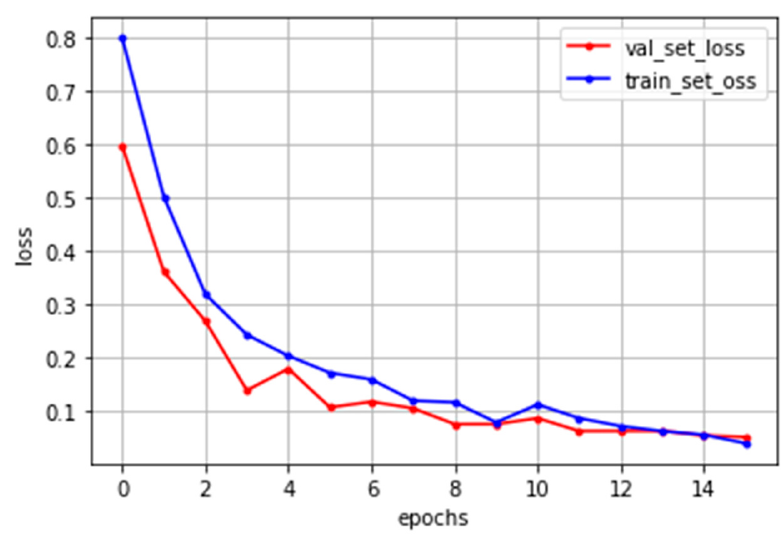
Figure 12. Dotted defect CNN model training result.